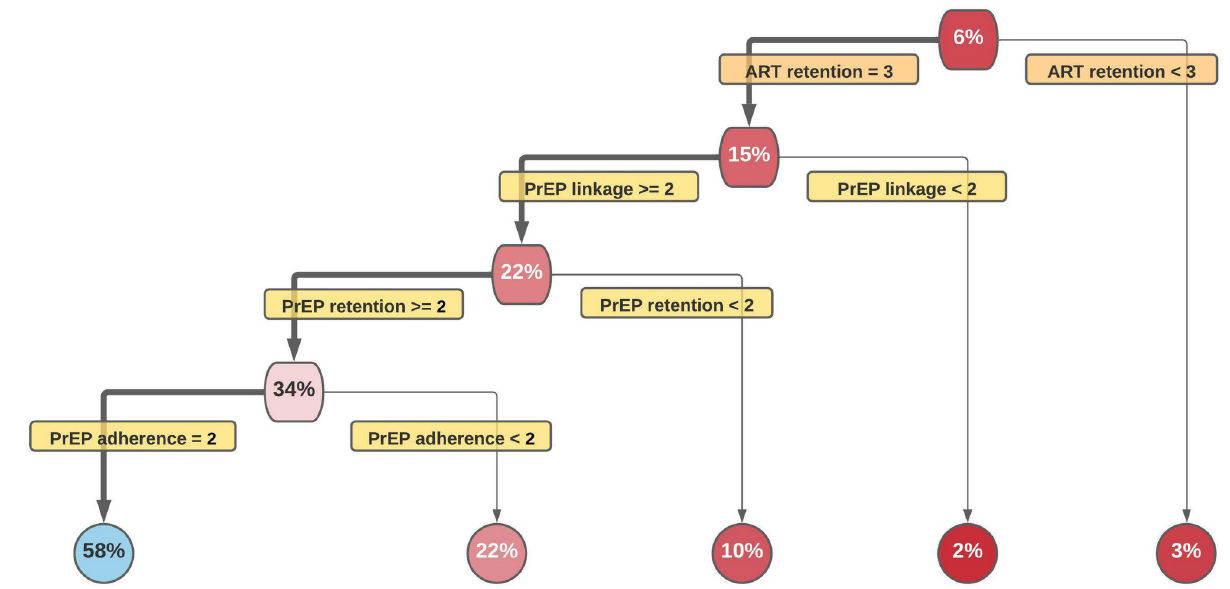
Fig 4. Pathways toward final EHE goal, 90% reduction of incidence by